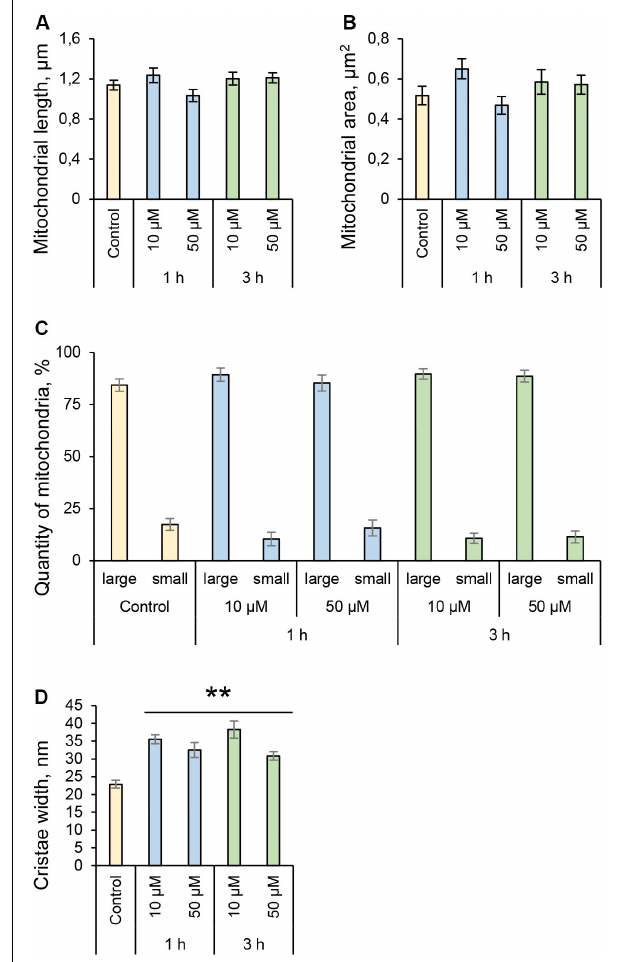
FIGURE 5 | Quantification of mitochondria dynamics and ultrastructure in epithelial Caco-2 cells stimulated with 3O-C 12 -HSL. (A) Mitochondrial length, µ m. (B) Mitochondrial area, µ m 2 . (C) Quantity of mitochondria, %. Large organelles were considered as > 0,2 µ m 2 and small as < 0,2 µ m 2 . (D) Cristae width, nm. Columns represent the mean ± SE. Significant differences are indicated with ** when P < 0.01, as analyzed by two-tailed Student’s t -test. Data from three different experiments performed on separate days on different cell passages, and at least 300 mitochondria in different cells per condition were